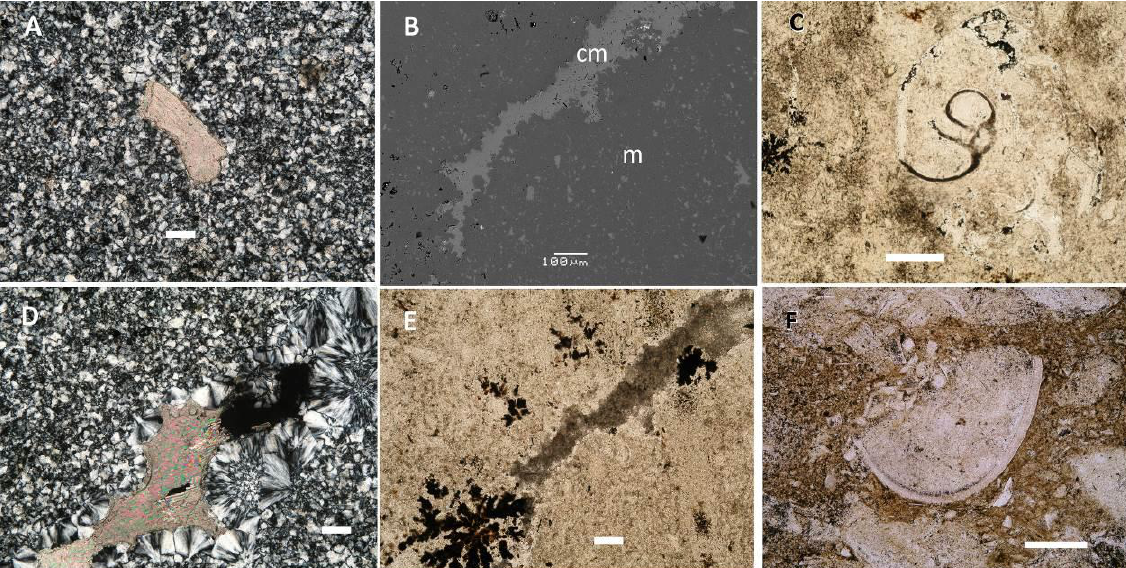
Figure 14. Microphotographs from thin polished sections. A: Preservation of a calcite shell fragment within the siliceous matrix (optical microscopy, crossed polarisers). B: BSE image showing replacement of a micritised calcite shell (cm) by silica (dark grey) of the matrix (m). C: Gastropod shell fragment floating in a silica matrix (optical microscopy, plane polarised light). D: microcrystalline quartz with a diagonal void filled with a first generation of radial fibrous chalcedony followed by a late sparite mosaic (optical microscopy, crossed polarisers). E: Same area as B (optical microscopy, plane polarised light). F: Bioturbated area with diverse bioclast (optical microscopy, plane polarised light). Scale: 100 μm (A, B, D, E) and 500 μm (C,